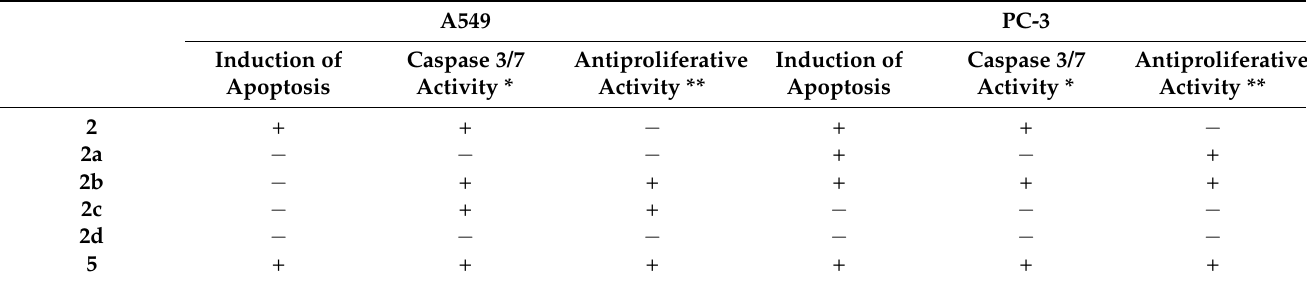
Figure 4. Caspase-3/7 activity of tested compounds after 24 and 72 h. * statistically significant versus control, p < 0.05. Compounds were tested in concentrations of about 1.5 × IC 50 . Table 7. Comparison of antiproliferative and caspase-3/7 activities of tested compounds on A549 and PC-3 cell